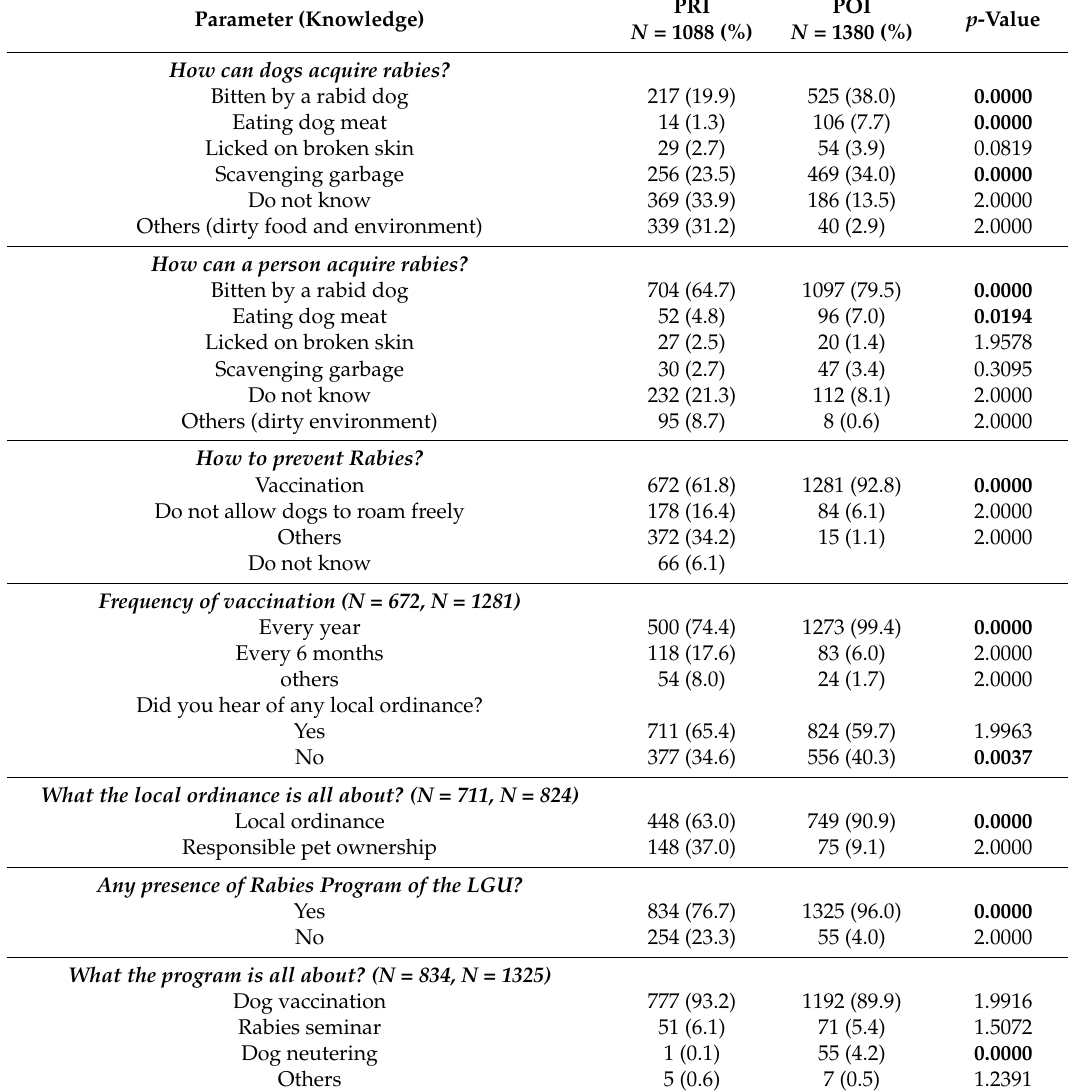
Table 3. Knowledge on rabies, its prevention, and presence of government rabies